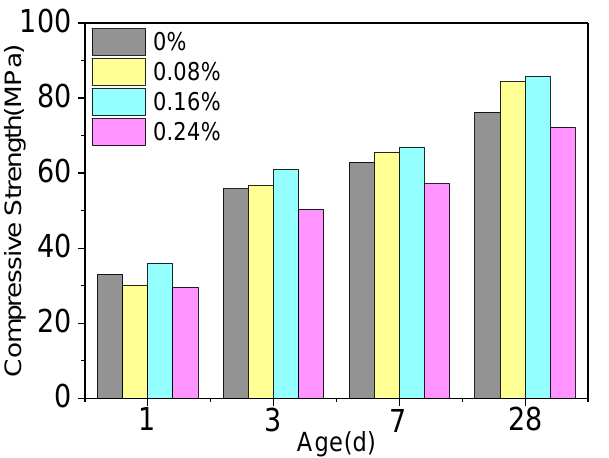
Figure 3. Compressive strength changes of cement paste at 1, 3, 7, and 28 d with different contents of NSN.